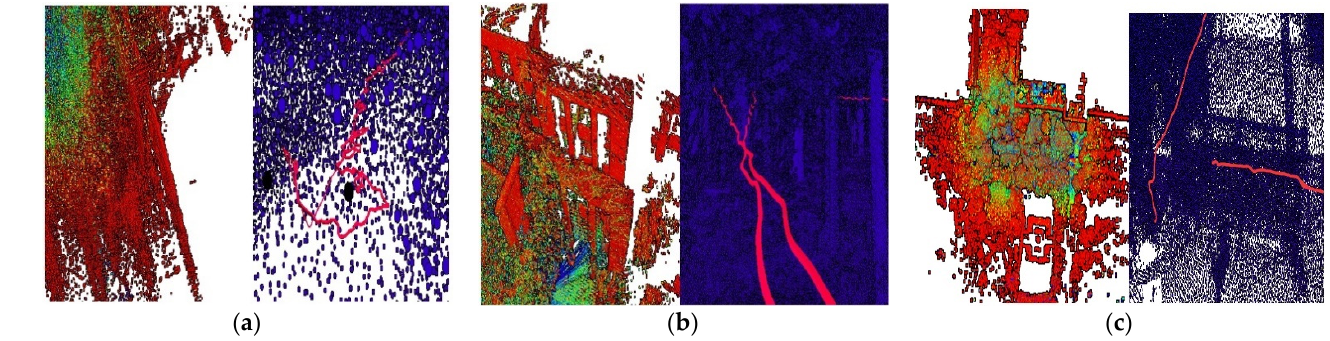
Figure 9. Laser odometer diagram of three paths. (( a ) shows straight-line path error; ( b ) shows S- type line path error; ( c ) shows loop path).